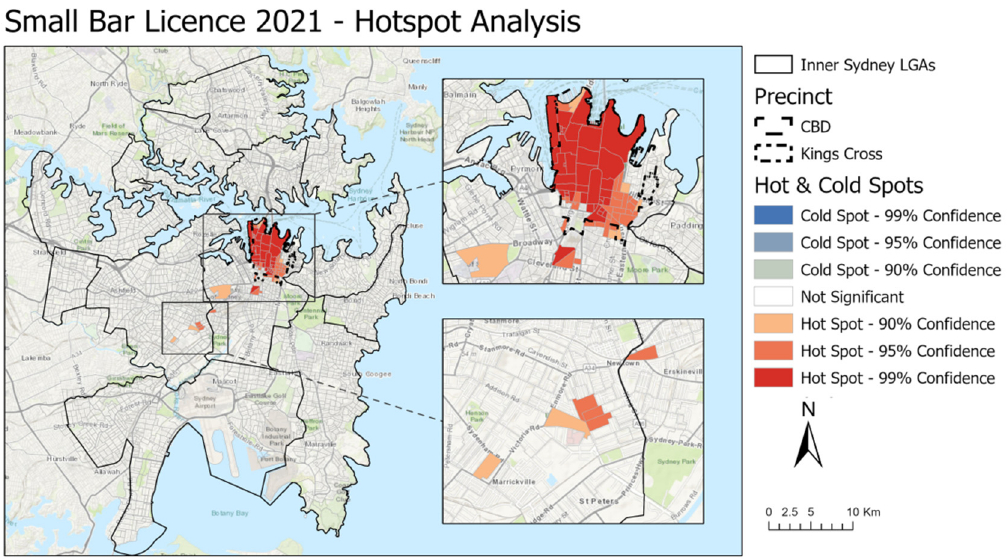
Figure 10. Small bar licence hotspots 2021.